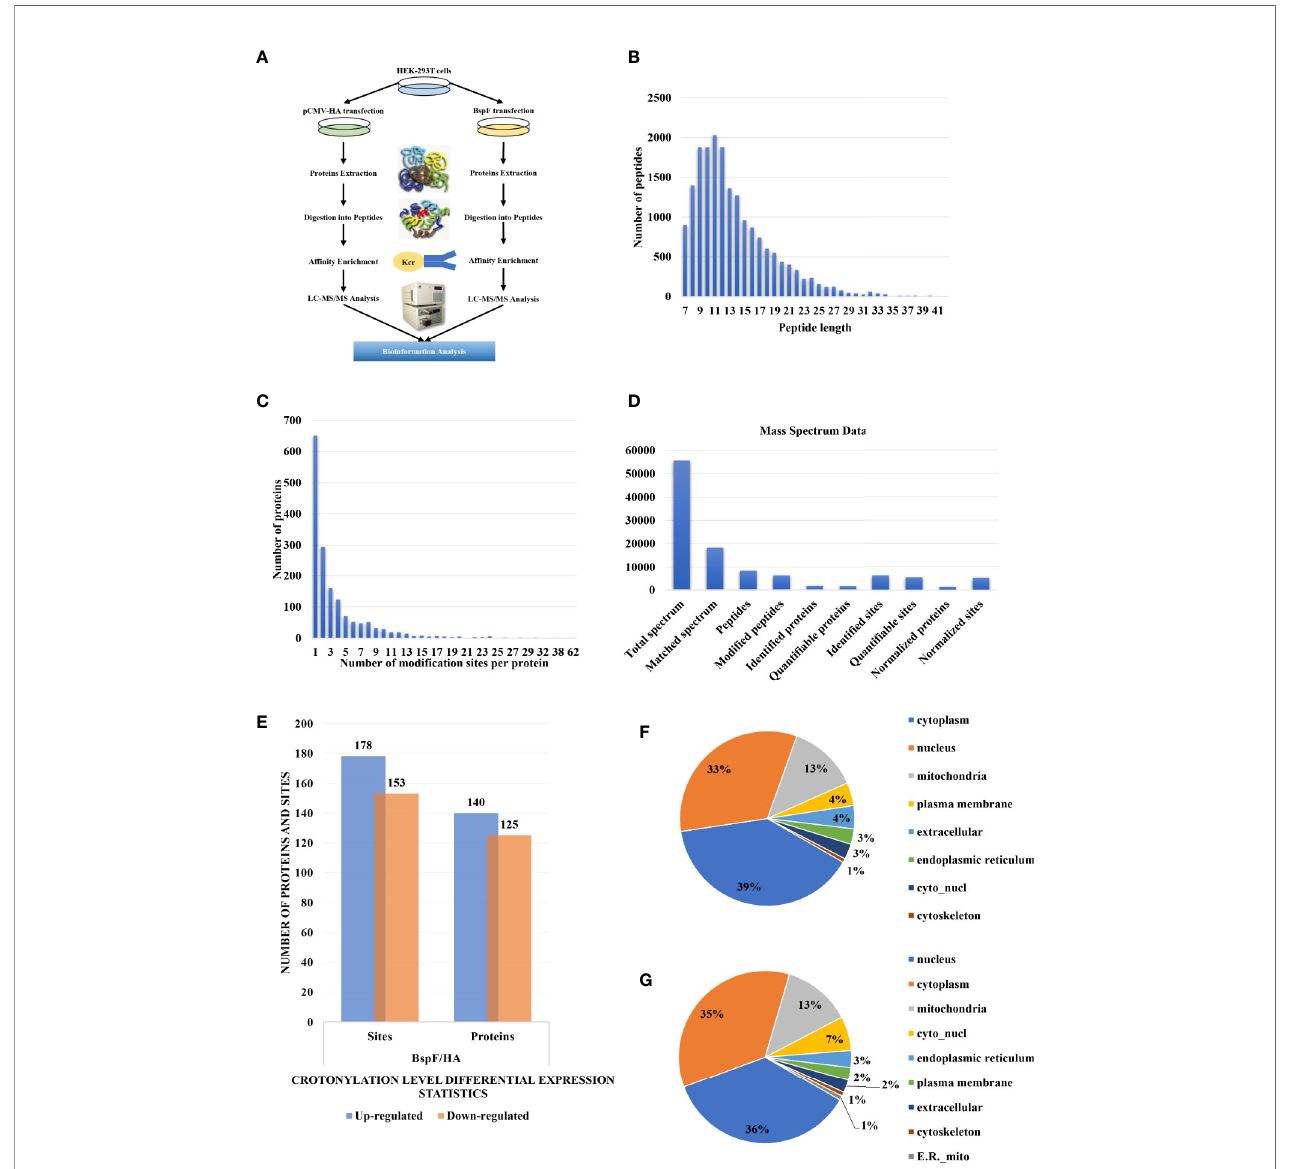
FIGURE 3 | Overview of crotonylation identi fi cation in HEK-293T cells. (A) Flowchart of the analysis of crotonylation in HEK-293T cells. (B) Distribution of tryptic peptide lengths. (C) Number of K Cr sites per protein. (D) Numbers of proteins and sites that were identi fi ed and quanti fi ed by MS/MS. (E) Differential expression statistics of protein and site modi fi cation levels. (F, G) Subcellular localization of proteins containing (F) up-regulated and (G) down-regulated K Cr sites in HEK-293T